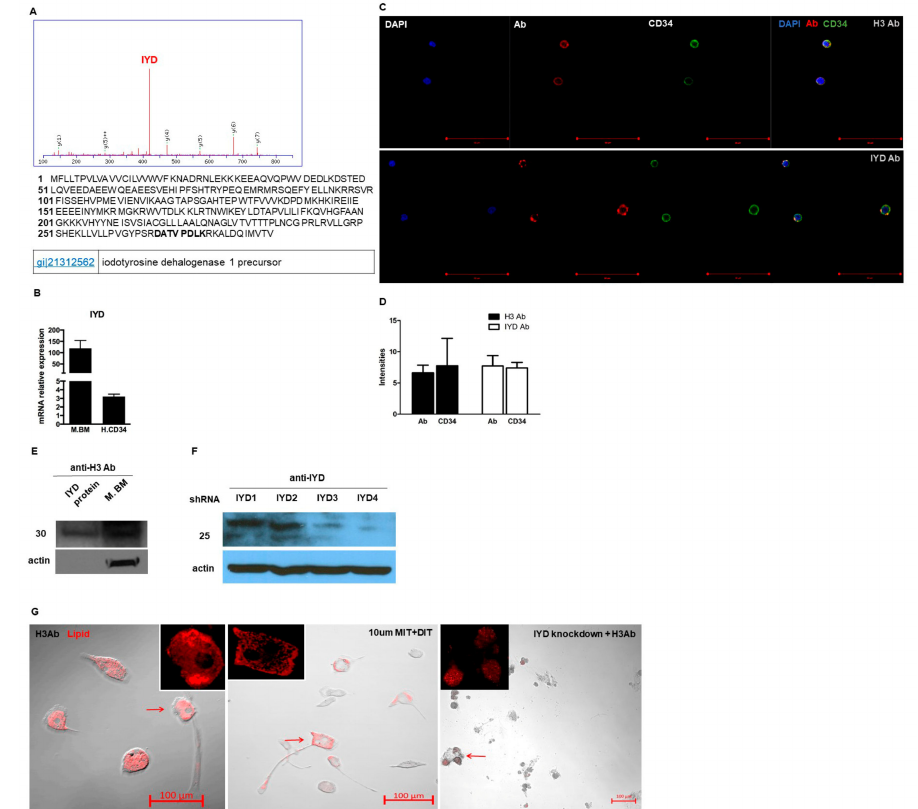
Figure 4. IYD is the novel target of the H3 Ab. ( A ) Murine bone marrow lysates were mixed with H3 Ab to immune-precipitate binding proteins and were then analyzed by silver staining and Nano-LC-MS / MS. IYD peptides are highlighted in bold. ( B ) Total RNA was extracted from murine bone marrow and human CD34 + cells to compare IYD expression by qRT-PCR. ( C ) Human CD34 + cells were stained with DAPI, H3 Ab, commercial anti-IYD, or anti-CD34 antibody to confirm surface expression of IYD by confocal microscopy. Scale bars = 50 µ m. ( D ) Graph of fluorescence intensities from staining hCD34 + cells with H3 Ab or commercial IYD Ab. ( E ) The H3 Ab recognized human IYD protein and murine bone marrow lysates when analyzed by Western blotting. ( F ) IYD commercial antibody bound to IYD shRNA-treated cell lysates in Western blots. ( G ) Mouse bone marrow cells were incubated with H3 Ab, IYD substrates, or H3 Ab + IYD shRNA. Staining with the Lipidtox adipocyte marker revealed no cell di ff erentiation in H3 Ab + IYD shRNA-treated bone marrow. Red arrows indicate adipocyte-like cells (Magnification: 20 ×